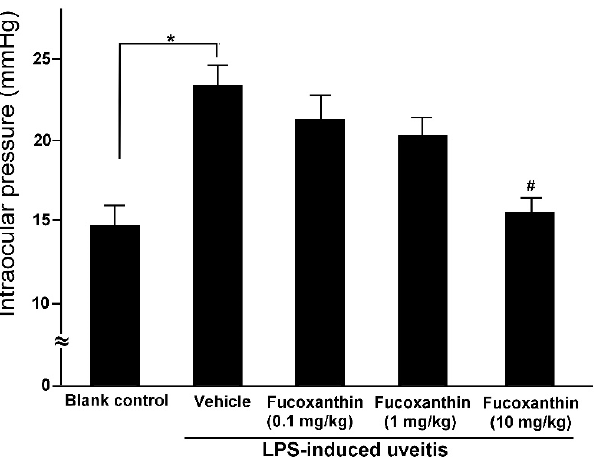
Figure 2. Effects of fucoxanthin on IOP after LPS-induced uveitis. The IOP values were compared among the blank control, LPS/vehicle, LPS/0.1 mg/kg BW of fucoxanthin, LPS/1 mg/kg BW of fucoxanthin, and LPS/10 mg/kg BW of fucoxanthin groups. Compared to the blank control group, the IOP was significantly elevated in the LPS-treated group, but the IOP then decreased with fucoxanthin treatment. The results are presented as the means ± SD ( n = 5 rats/group). * p < 0.05: Significantly different compared to the blank control group (Student’s t -test). # p < 0.05: Significantly different in the